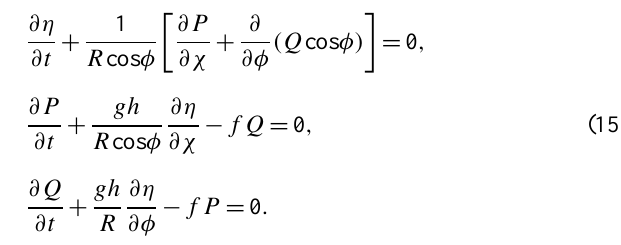
Russian navigation charts and Korean hydrographic